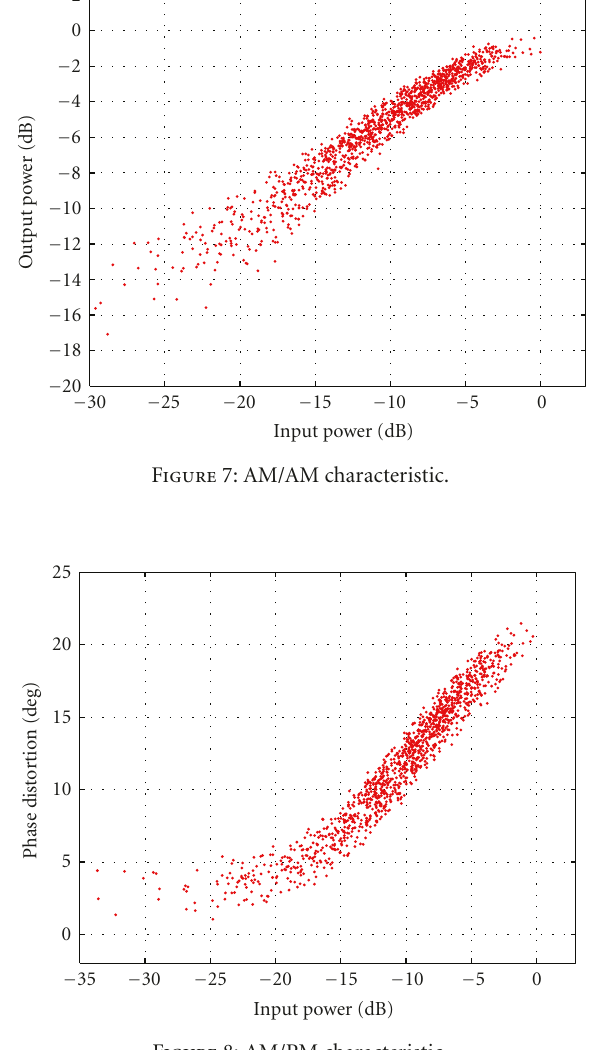
Figure 8: AM/PM characteristic.